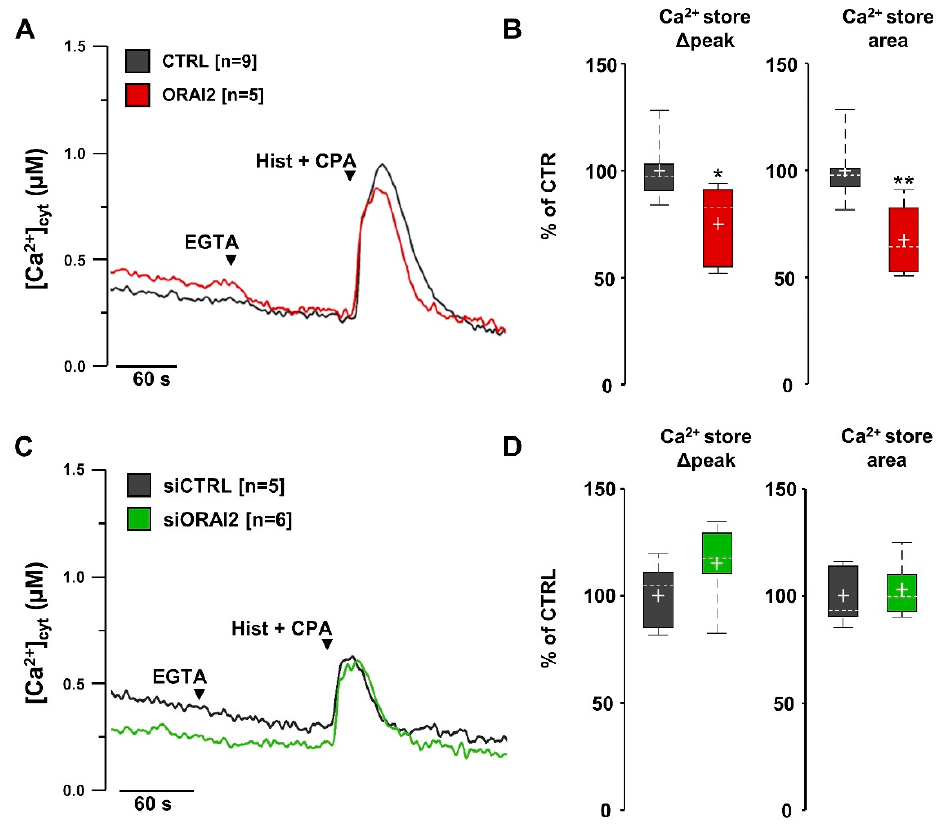
Figure 6. Overexpression, but not downregulation, of ORAI2 modulates the IP 3 -sensitive Ca 2 + stores of H4-APPswe cells. In H4-APPswe cells, overexpression of ORAI2-myc (plus STIM1) decreases the IP 3 -induced ER Ca 2 + release while its downregulation by siRNA has no e ff ect. Cells were co-transfected with cyt-AEQ together with void-vector (CTRL) or cDNAs coding for ORAI2 and STIM1 ( A,B ) or siRNAs (siCTRL or siORAI2) ( C,D ). Cells were bathed for 2 min at 37 ◦ C with mKRB containing CaCl 2 (1 mM), then for one minute with a Ca 2 + -free mKRB, containing EGTA (0.6 mM), before being challenged with histamine (Hist, 100 µ M) and CPA (20 µ M) in the same medium, as indicated by the arrows. ( A,C ) Representative traces for CTRL (black), ORAI2-overexpressing (red) or siORAI2-transfected (green) cells, respectively. ( B,D ) Boxplots of Ca 2 + release, in terms of peak amplitude and AUC, upon baseline subtraction. Data are expressed as percentage of CTRL, n = number of coverslips, Wilcoxon-Mann-Whitney test, * p < 0.05, ** p < 0.01.